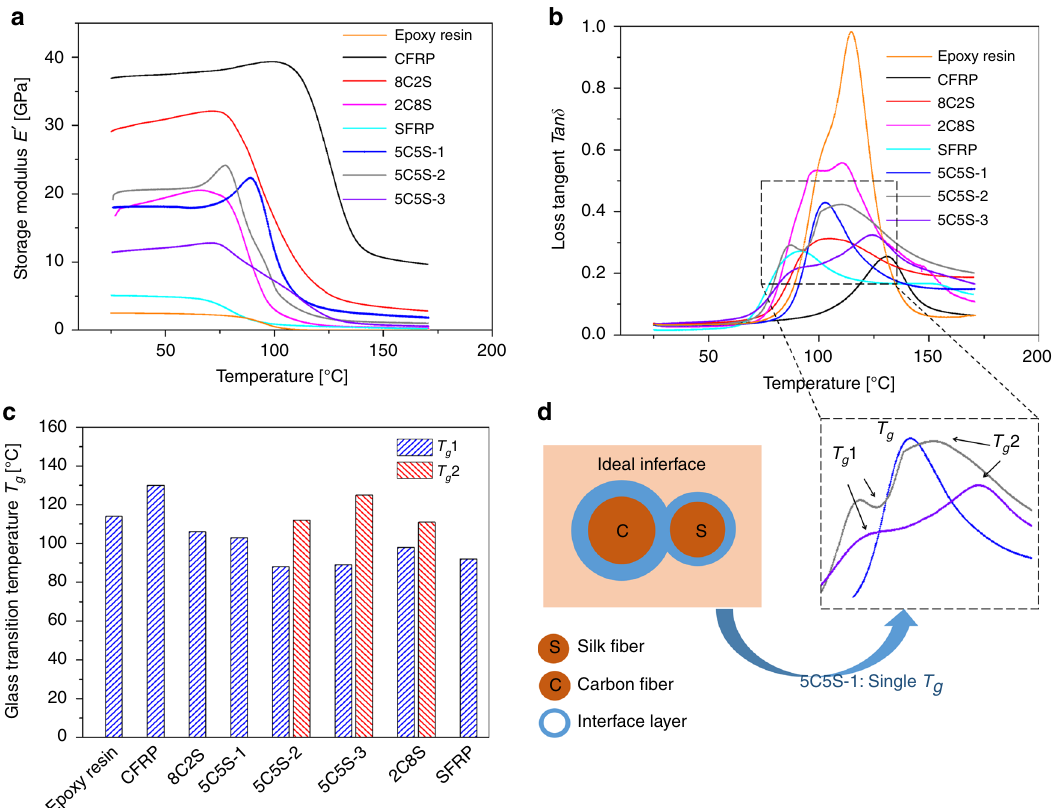
Fig. 6 DMTA of epoxy resin and composites. a Dynamic storage modulus ( E ’ ) pro fi les as a function of temperature from 25 °C to 170 °C. b Corresponding loss tangent tan δ pro fi les in the same temperature range. c The glass-transition temperatures T g of the epoxy resin and studied composites, as de fi ned by the peak tan δ . d Effect of an ideal interface in 5C5S-1 in in fl uencing the glass-transition temperatures T